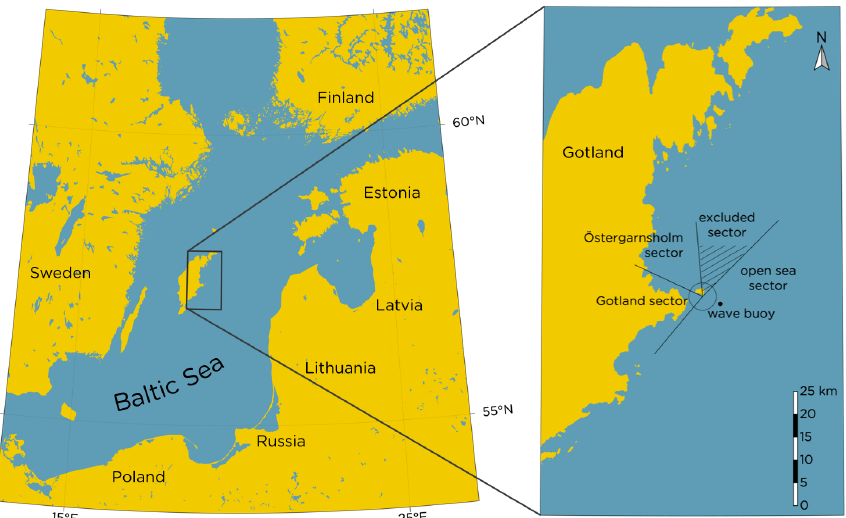
Figure 1. Overview of the Baltic Sea and the surrounding land areas. The circle in the inset has a radius of 3km and is centered at the position of the meteorological mast at Östergarnsholm, the small island just east of Gotland. The open-sea sector, the Gotland sector and the Östergarnsholm sector are marked in the inset together with the excluded sector from which no data were used. The position of the wave buoy is marked with the black dot in the